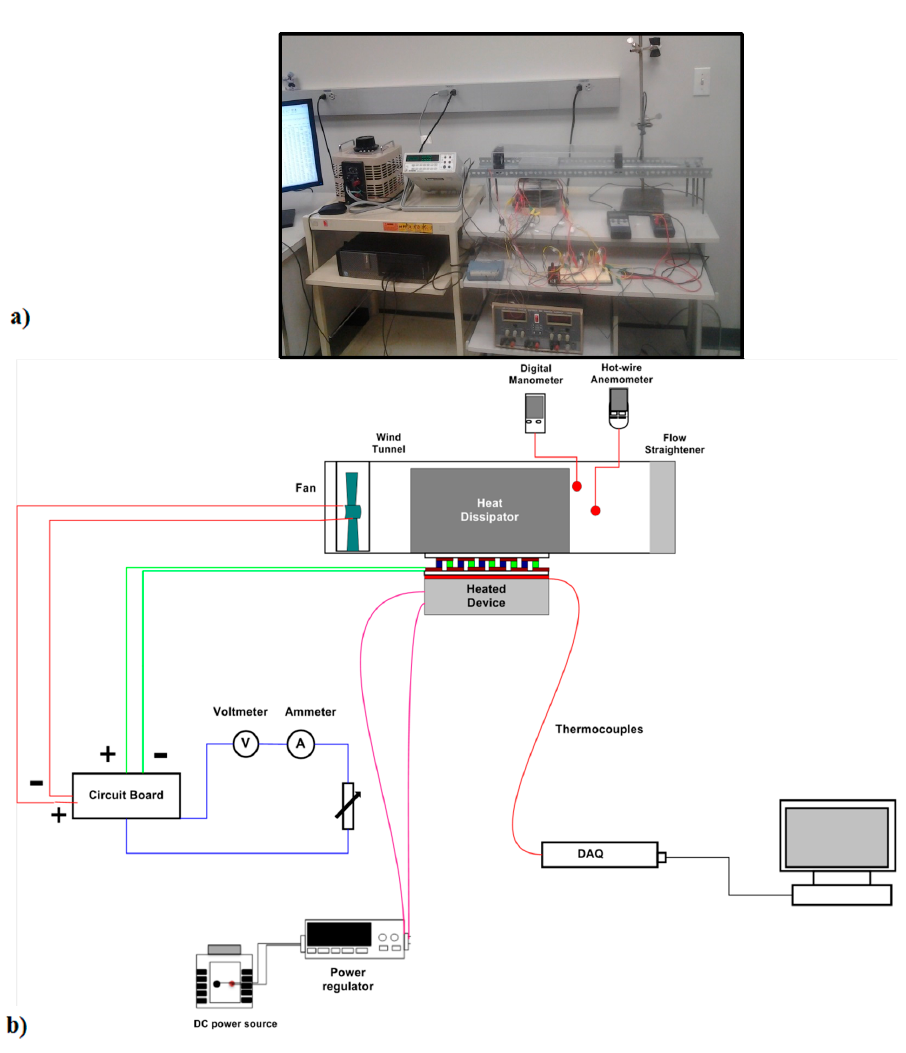
Figure 5. ( a ) Picture of experimental setup and ( b ) schematics of the investigation system. Table 2. Specification of thermoelectric generator module (model TEG241-1.0-1.2, China EVERREDTRONICS). tunnel and the average flow velocity, which was obtained by measurements at multiple points and area-weighted averaging method. A digital manometer (OMEGA) is used to monitor the